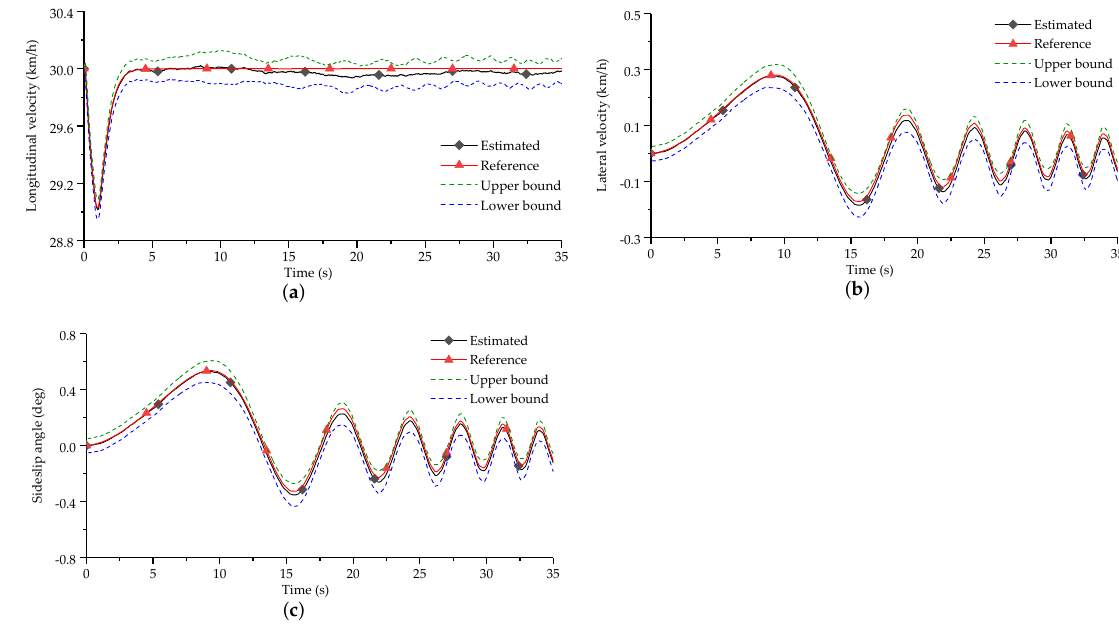
Figure 11. Results of the ESMF-based strategy under the slalom maneuver. ( a ) Longitudinal velocity; ( b ) Lateral velocity; ( c ) Vehicle sideslip